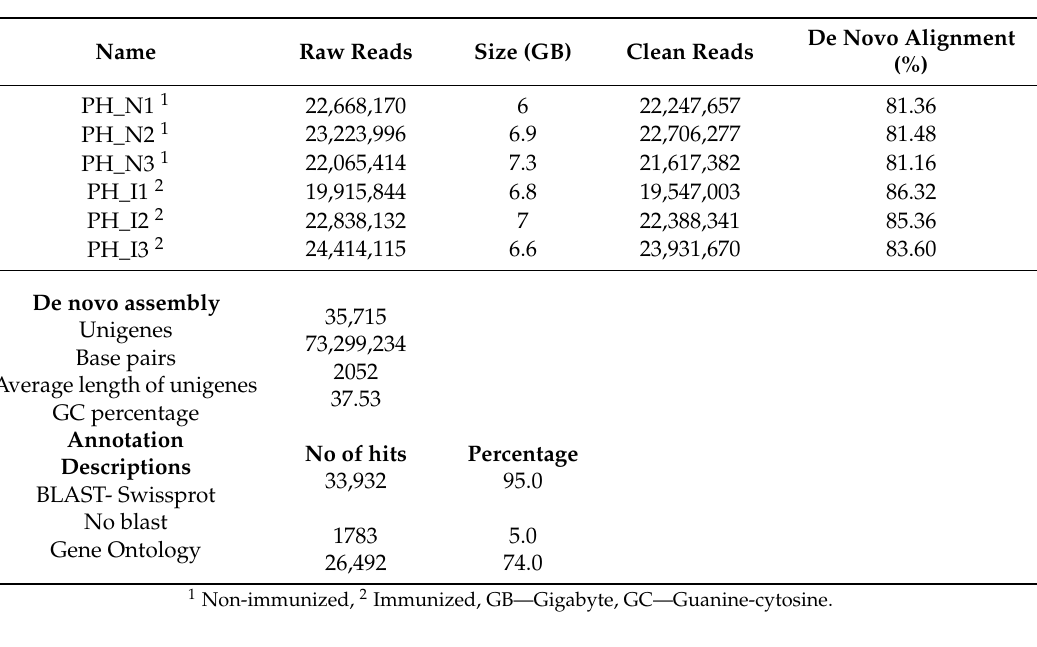
Table 1. Summary of sequencing and annotation.